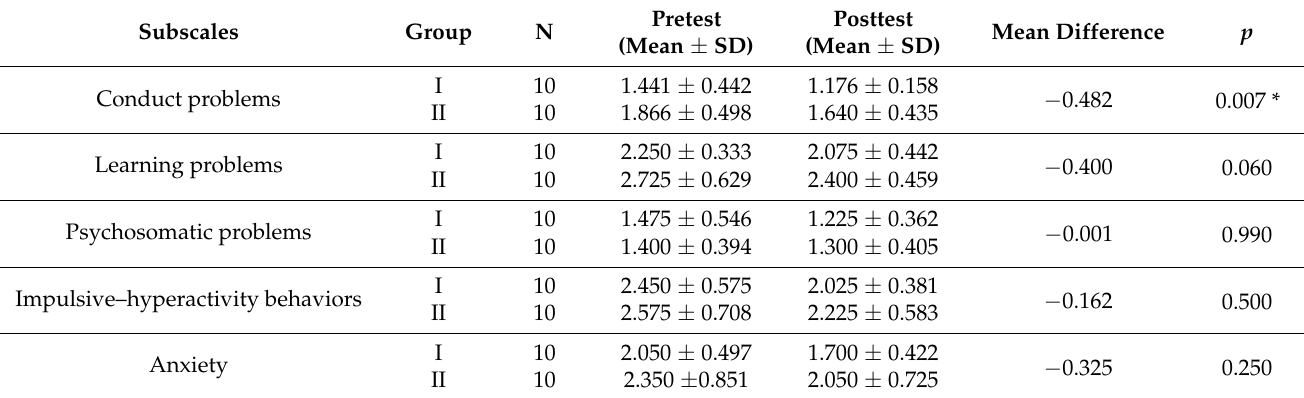
Table 1. The five subscales of Conner’s Parent Rating Scale-48 score of groups I and